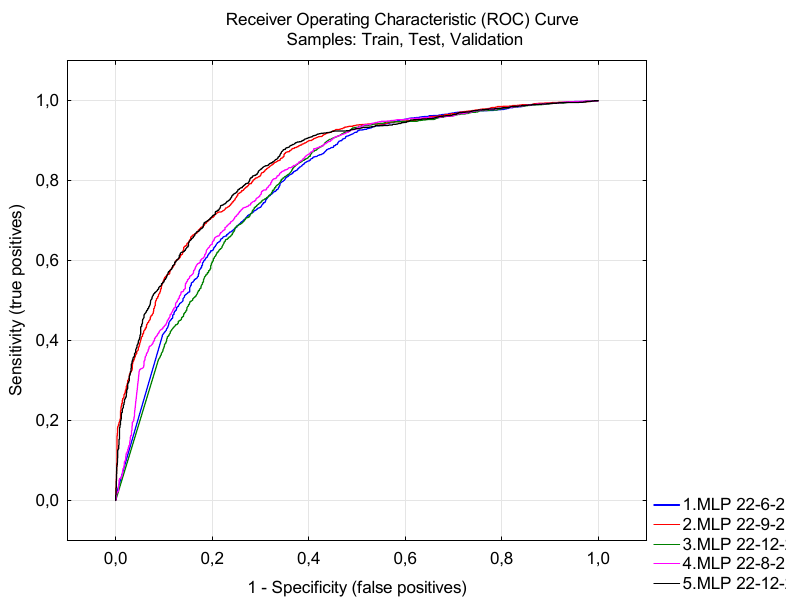
Figure 1. Threshold operating characteristics of neural network classification. Source: own construction.